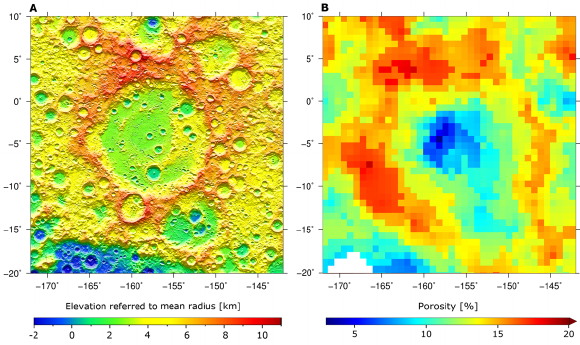
Figure 7. Korolev impact basin. The maps are presented in Mercator projection, with its meridian placed in the center of the basin. (A) Digital terrain model derived from LOLA data (Smith et al., 2017), elevations refer to mean topography radius of 1737.151 km, (B) Porosity of the upper lunar Figure 6. Porosity of the lunar crust (bulk densities were estimated applying the correlation approach). Projection and labels as in Fig. 4.